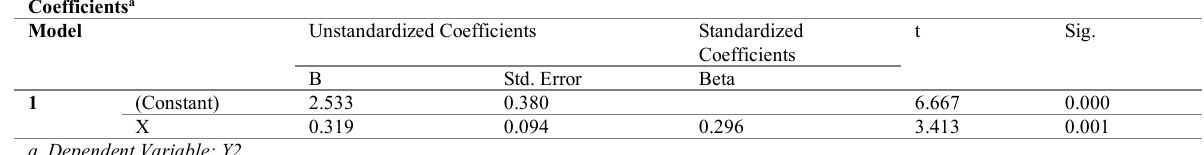
Table 7: Effect of Job Crafting on Job Satisfaction